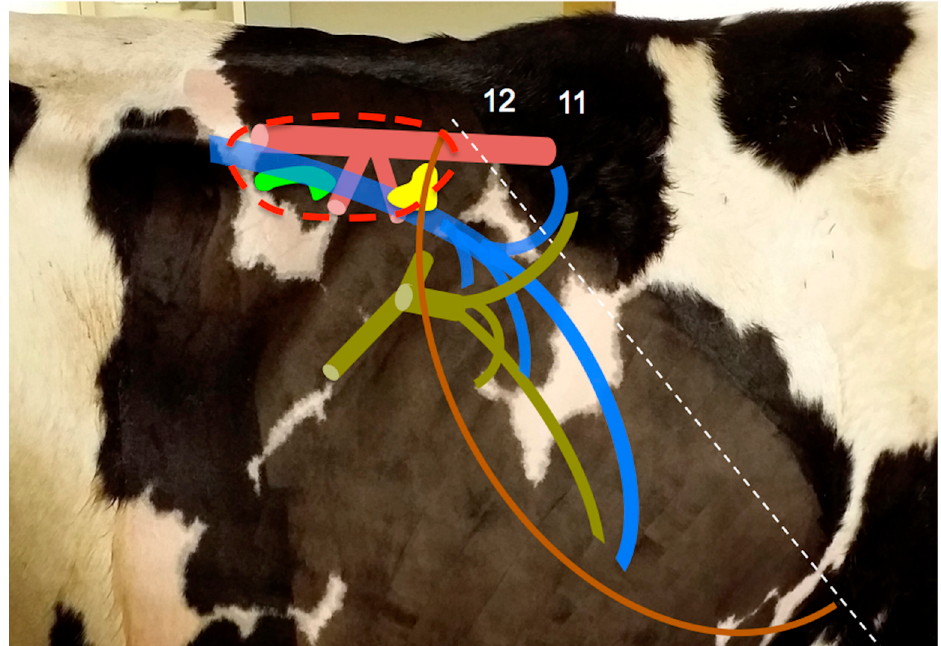
Figure 1. Schematic drawing of the anatomic location of the adrenal glands in the adult cow (sizes have been overrepresented). The right adrenal gland (yellow) can be found in the confluence of the right kidney (dotted red line), caudal vena cava (blue vessels) and the liver (brown line). The left adrenal gland (bright green) is ventral to the aorta (pinkish red) and caudal vena cava. Dark green: portal vein, its main tributaries and portal intrahepatic branches. Numbers indicate specific intercostal spaces. Dotted white line: projection of the caudal margin of the lung.